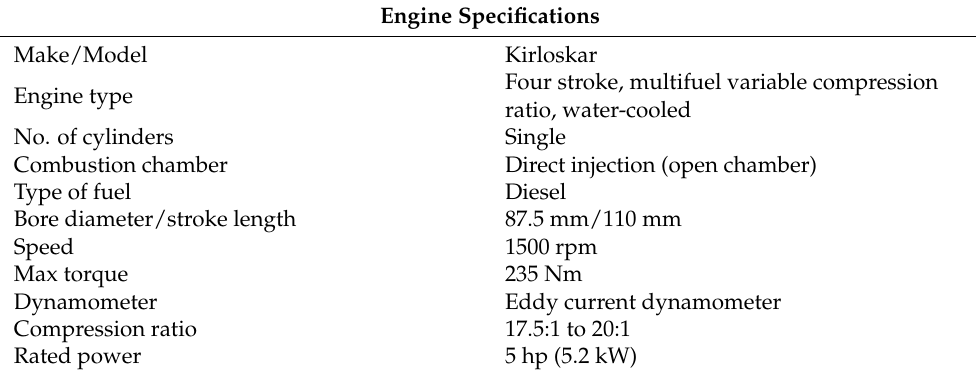
Table 1. Kirloskar engine